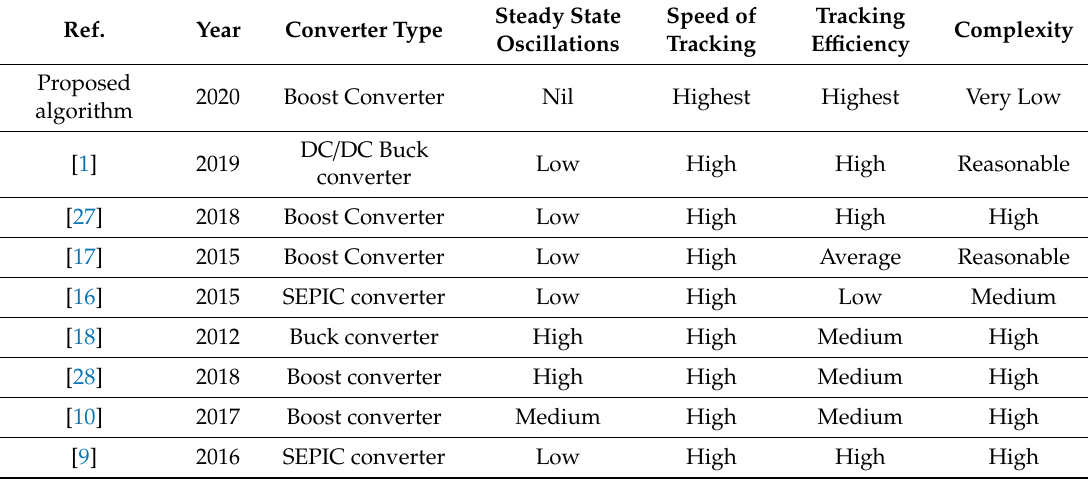
Performance evaluation of the proposed algorithm compared with well-known MPPT